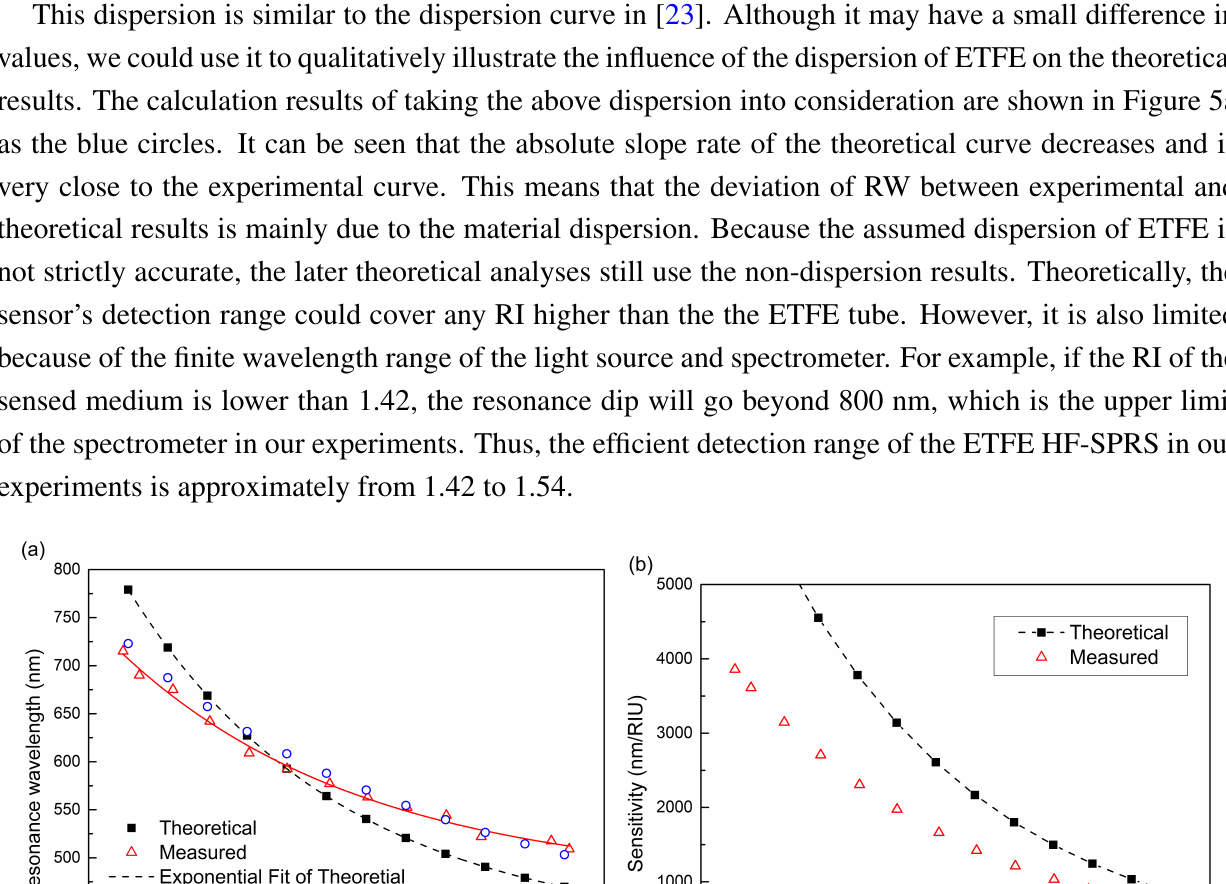
; ( b ) sensitivity versus n s s